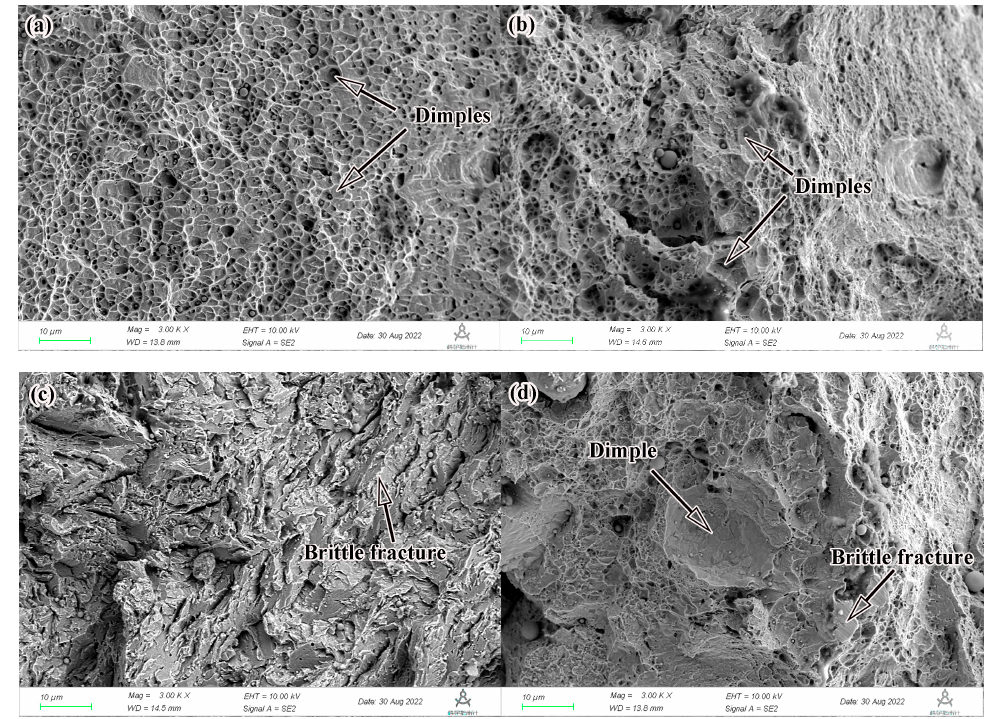
Figure 10. Tensile fracture morphology: ( a ) G20Mn5QT; ( b ) No. 5; ( c ) No. 8; ( d ) No. 9.